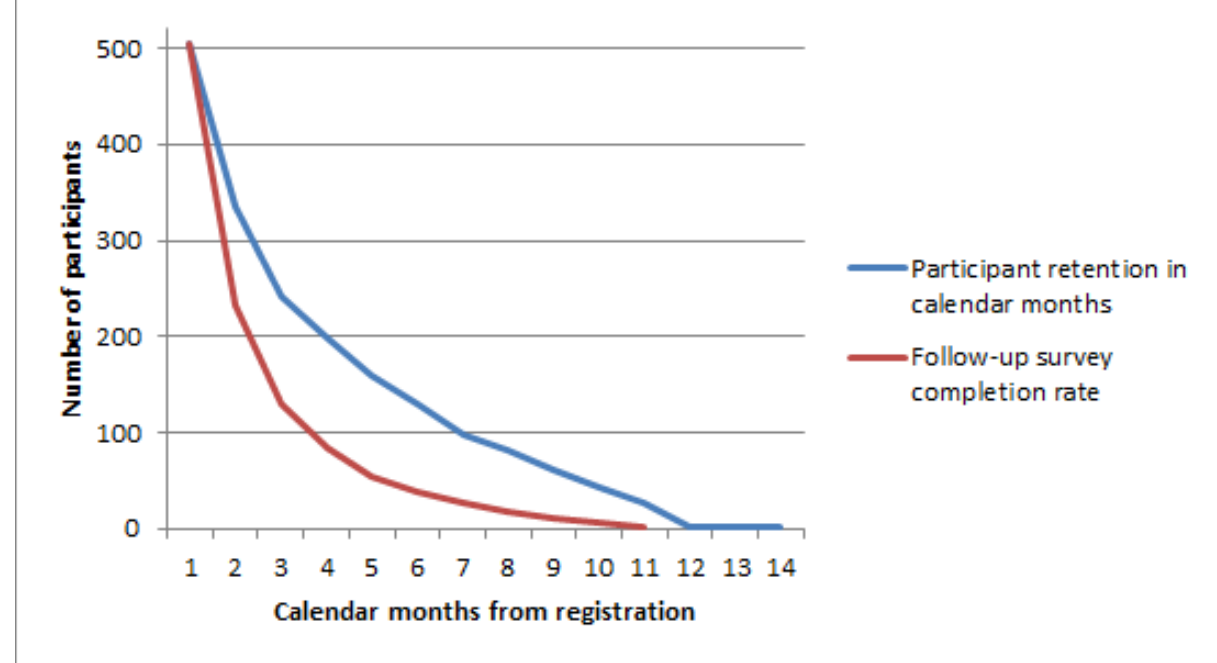
Figure 1. Participant retention and follow-up survey completion